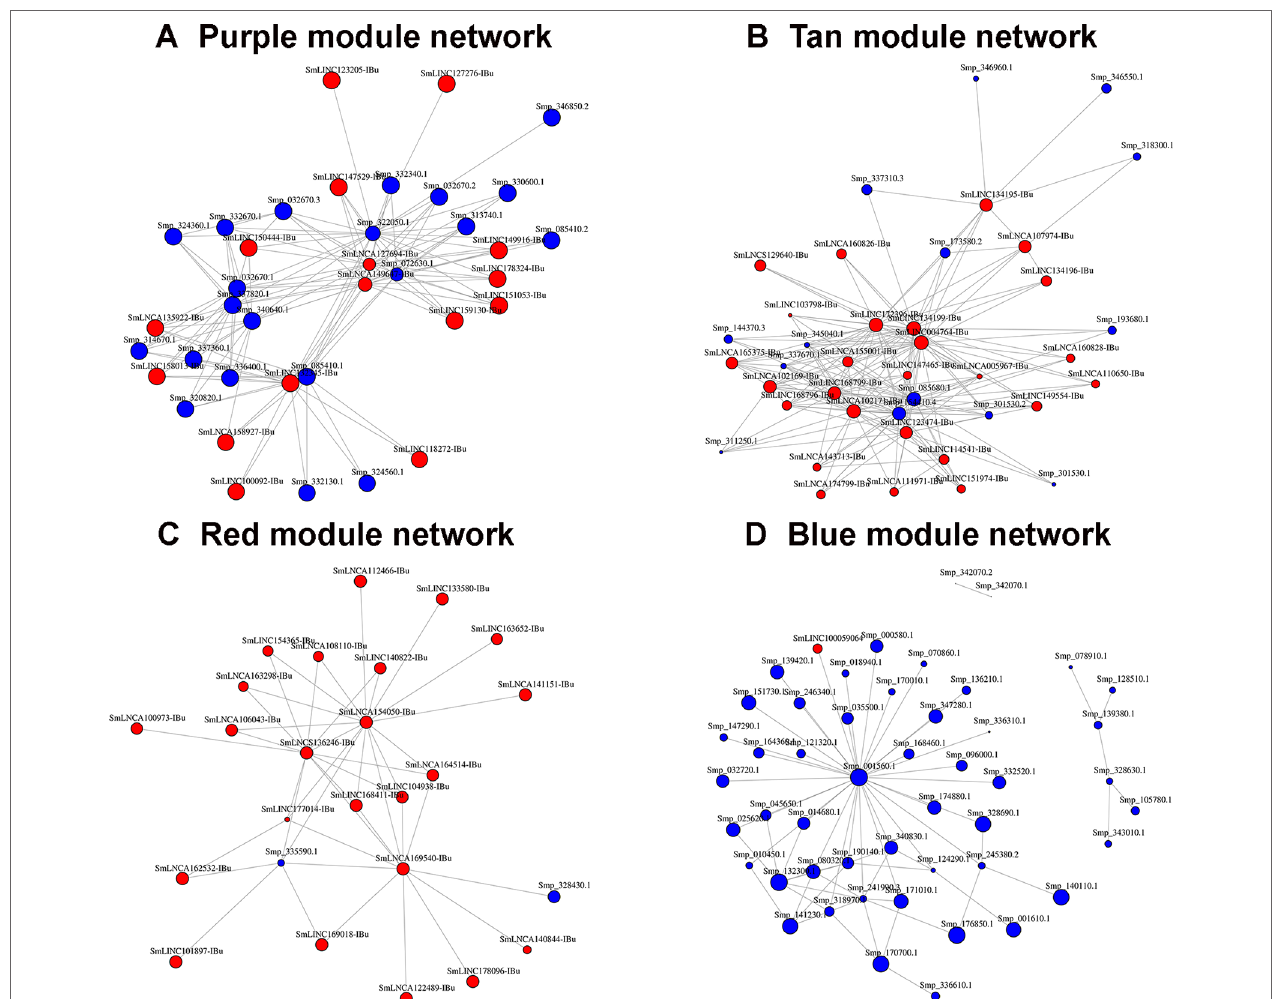
FIGURE 12 | Gene co-expression networks. The top most highly connected genes from the (A) purple (miracidia/sporocysts), (B) tan (cercariae), (C) red (testes) or (D) blue (females) co-expression network modules are shown. The adjacency thresholds are 0.77, 0.48, 0.58, and 0.26, respectively. Each red circle represents one lncRNA (SmLINC, SmLNCA, or SmLNCS), and each blue circle represents one protein-coding gene (Smp_). Circle sizes are related to the intramodular connectivity value for each